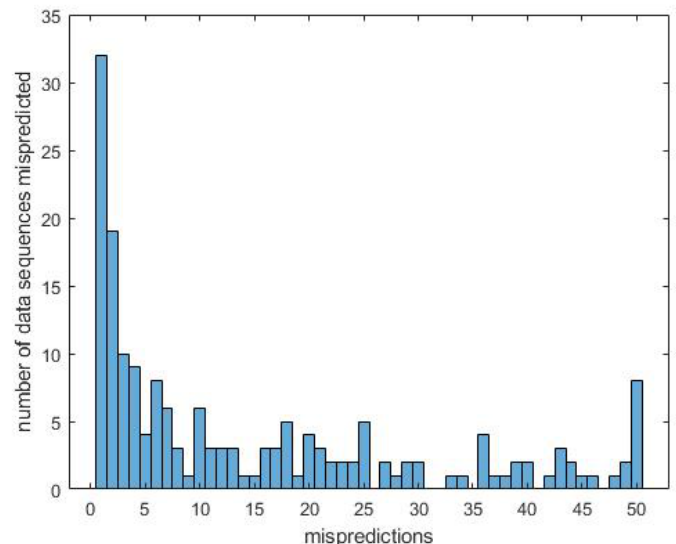
Figure 6. This histogram shows the 2630 mispredicted data sequences distributed over the accumulated mispredictions of the data